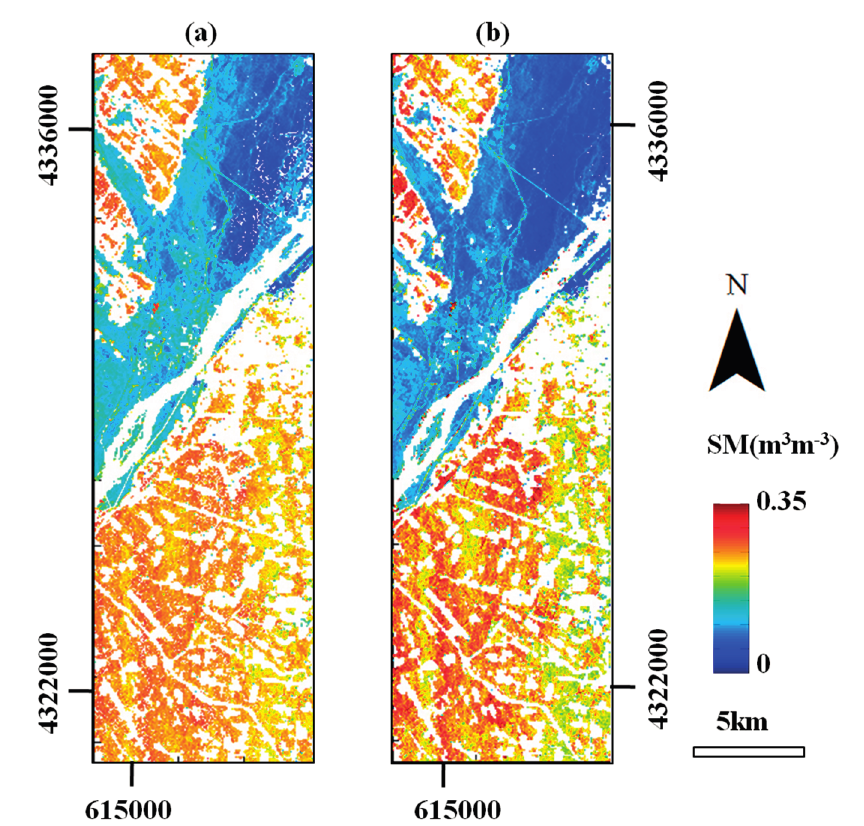
Figure 9. SM estimations in the study area. ( a ) The SM estimation from EF space. ( b ) The SM estimation from TVDI /Fr ∆T (cid:2929) (cid:2888)